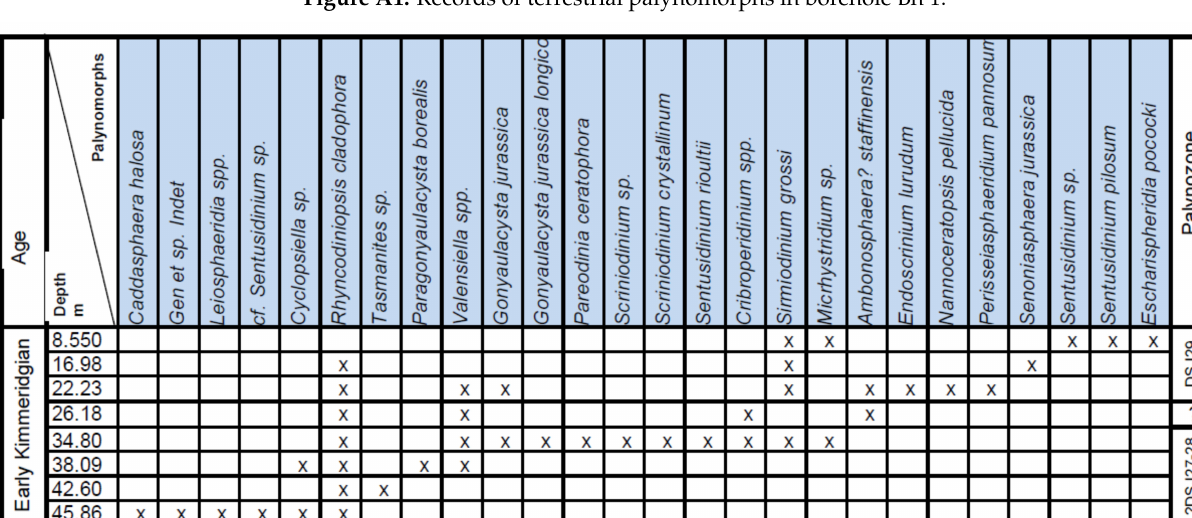
Figure A1. Records of terrestrial palynomorphs in borehole Bh 1.